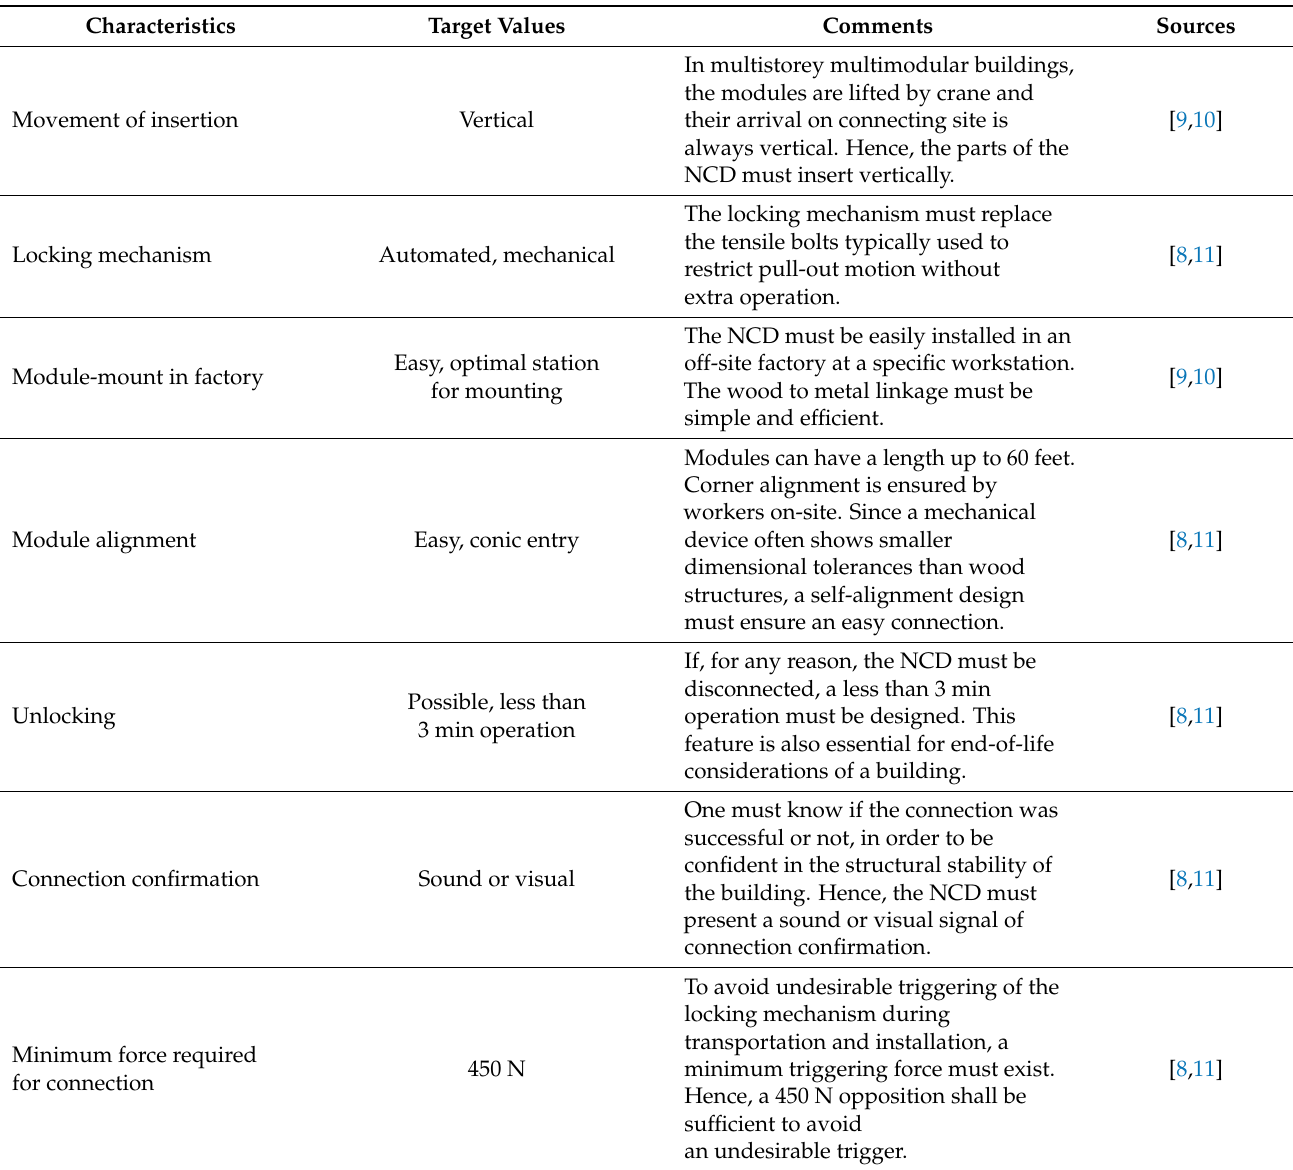
Table 1. Functional and technical design specifications for the